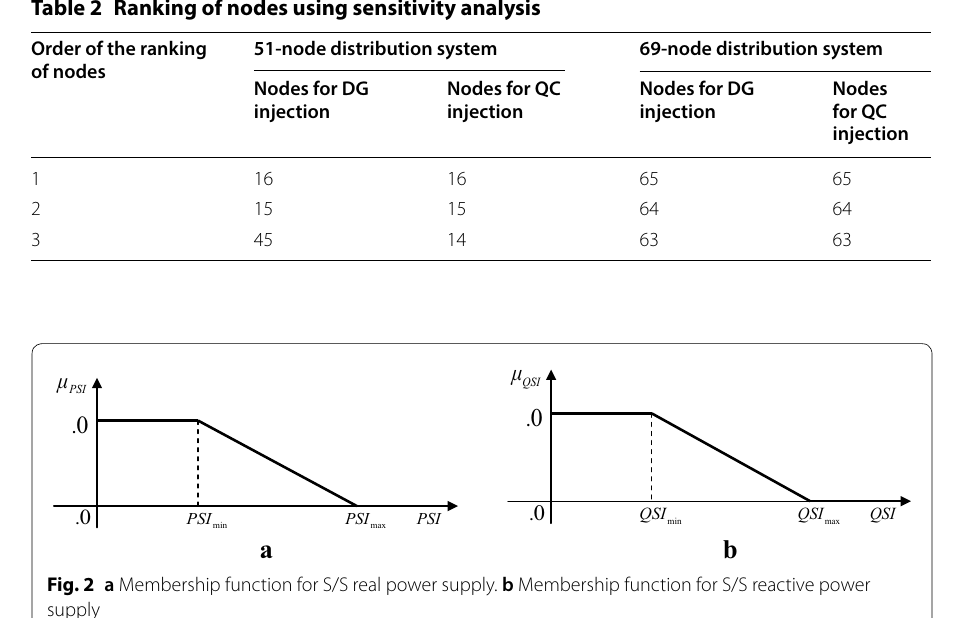
Nodes for DG injection